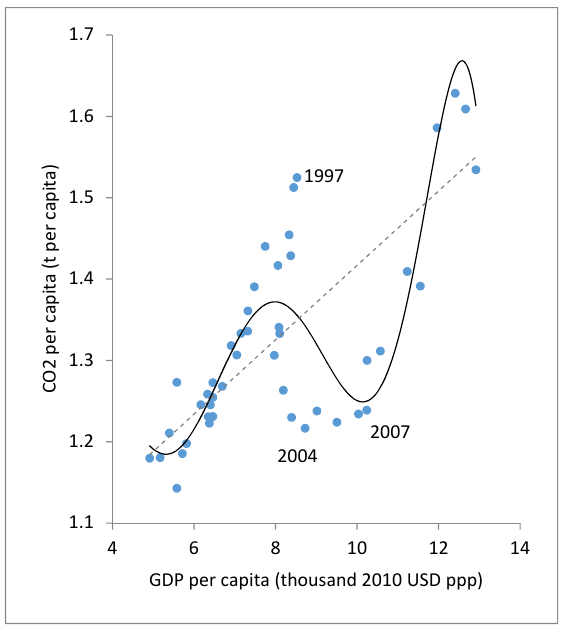
Figure 4. Relationship between CO 2 emissions and GDP. (Source: Produced by the authors with IEA data [4]).